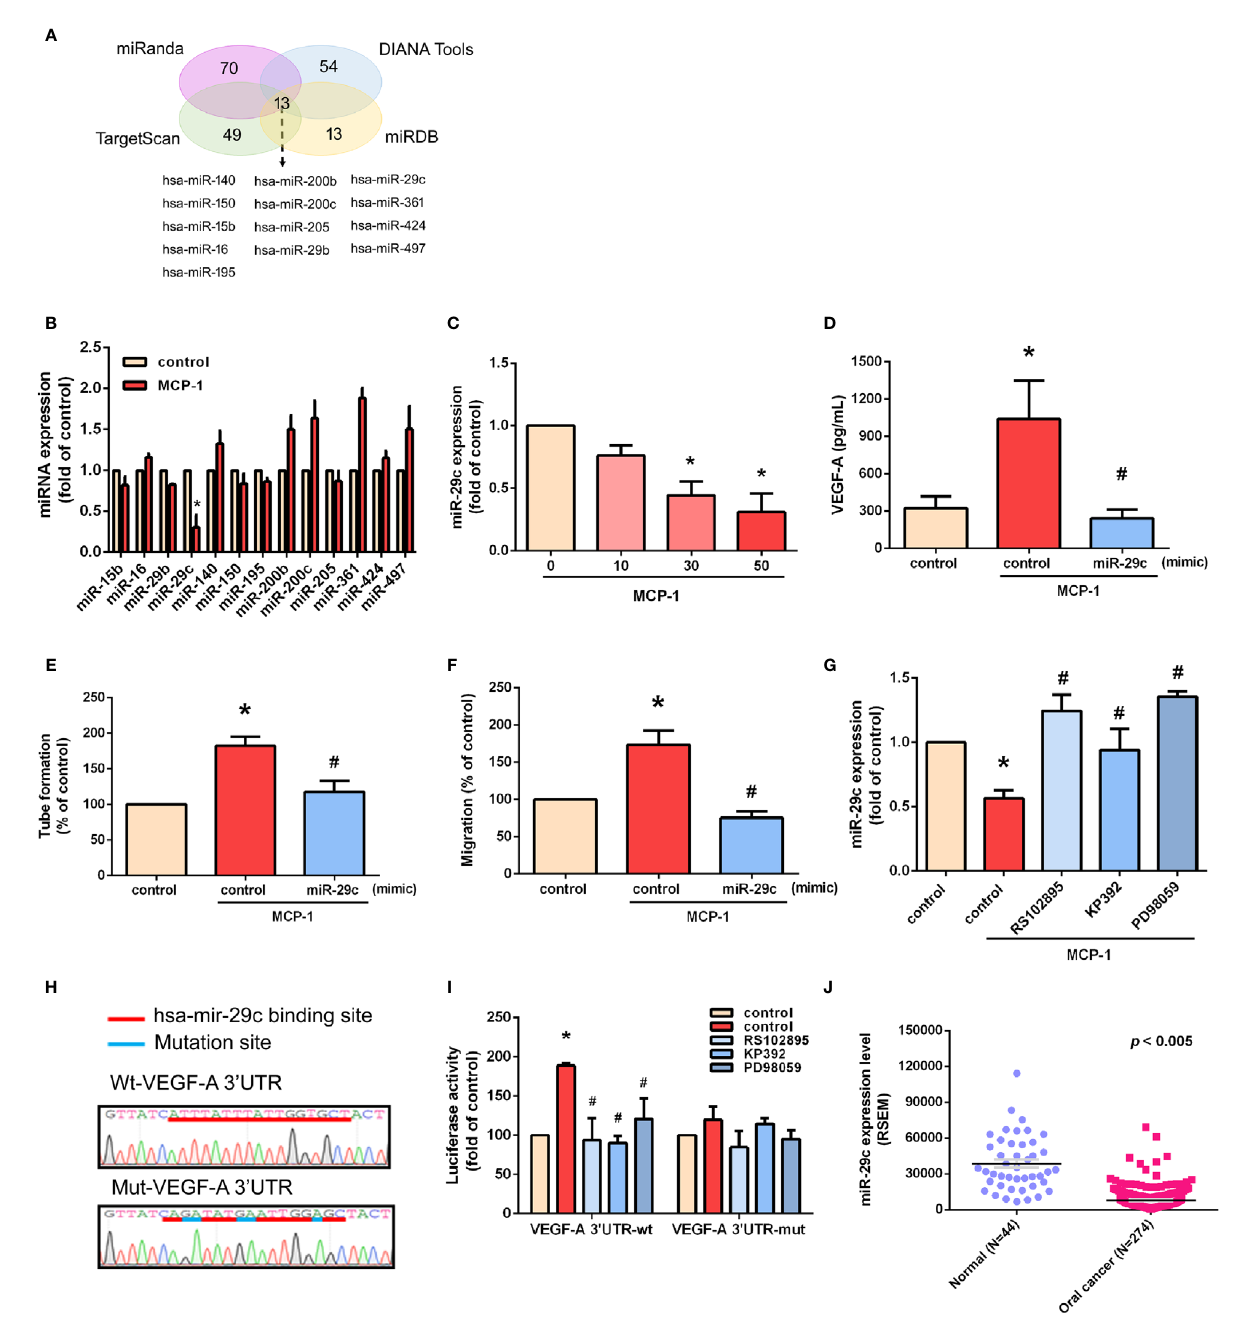
FIGURE 5 | miR-29c is a key miRNA in MCP-1 – induced stimulation of VEGF-A expression and angiogenesis. (A) MiRNA target prediction program software was used to identify miRNAs that potentially bind to the VEGF-A 3'-UTR. (B) Cells were incubated with MCP-1 for 24h and expression levels of the indicated miRNAs were subjected to qPCR analysis. (C) Cells were incubated with MCP-1 (0 – 50 ng/ml) for 24 h and miR-29c expression was determined by qPCR. (D) Cells were transfected with miR-29c mimic (10 nM) then incubated with MCP-1 for 24h. VEGF-A expression was measured by ELISA. (E, F) CM was applied to EPCs for 24 h then capillary-like structure formation was examined by the tube formation assay and cell migration by the Transwell assay. (G) Cells were treated for 30 min with RS102895 (100 ng/ml), KP392 (10 m M), or PD98059 (10 m M) then incubated with MCP-1 for 24 h. miR-29c expression was examined by qPCR analysis. (H) The wild-type or mutant VEGF-A 3'-UTRs containing the miR-29c binding site was inserted into the pmirGLO vector. (I) Cells were transfected with wt-VEGF-A-3'-UTR or mut-VEGF-A-3'-UTR plasmid for 24 h, then stimulated for 30 min with RS102895 (100 ng/ml), KP392 (10 m M), or PD98059 (10 m M), followed by MCP-1 treatment for 24 h; luciferase activities were measured. (J) TCGA database records were analyzed for levels of miR-29c expression in tumor tissue and adjacent normal tissue. * p < 0.05 compared with controls; # p < 0.05 compared with MCP-1 – treated controls. Each experimental procedure was independently repeated three times, with similar